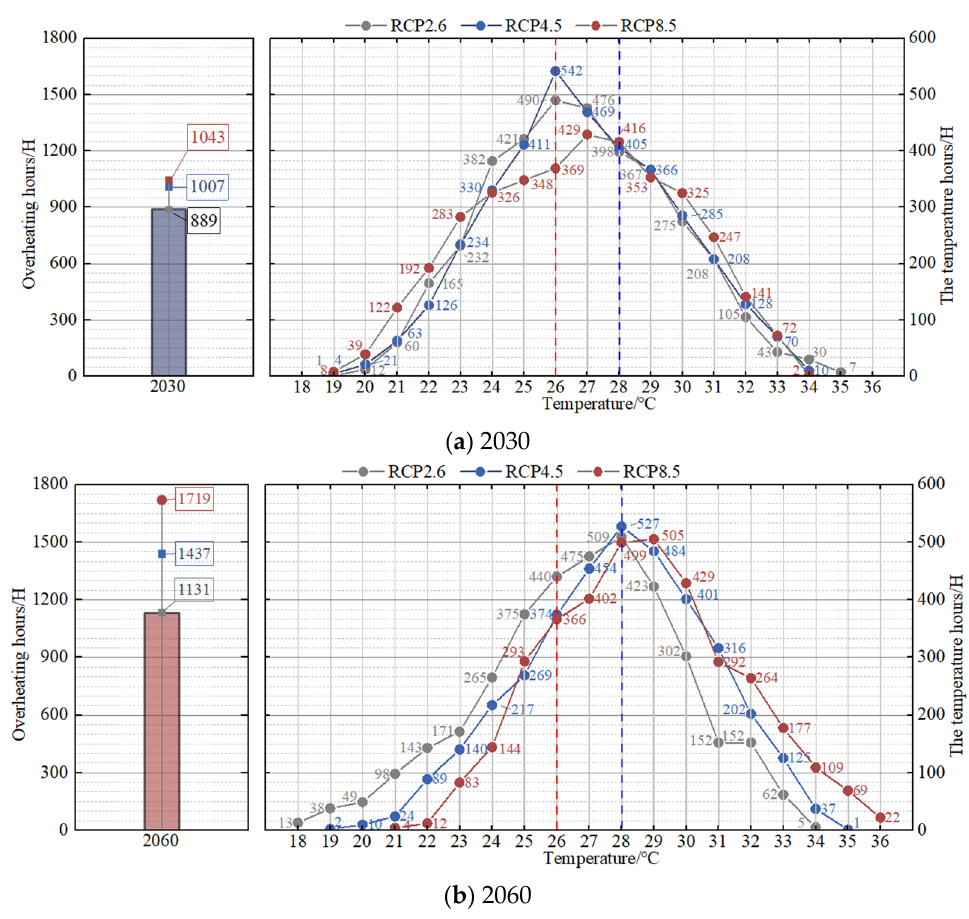
Figure 14. Overheating hours and the distribution of temperature hours in different carbon emission scenarios during summertime (May to September) for 2030 and 2060.